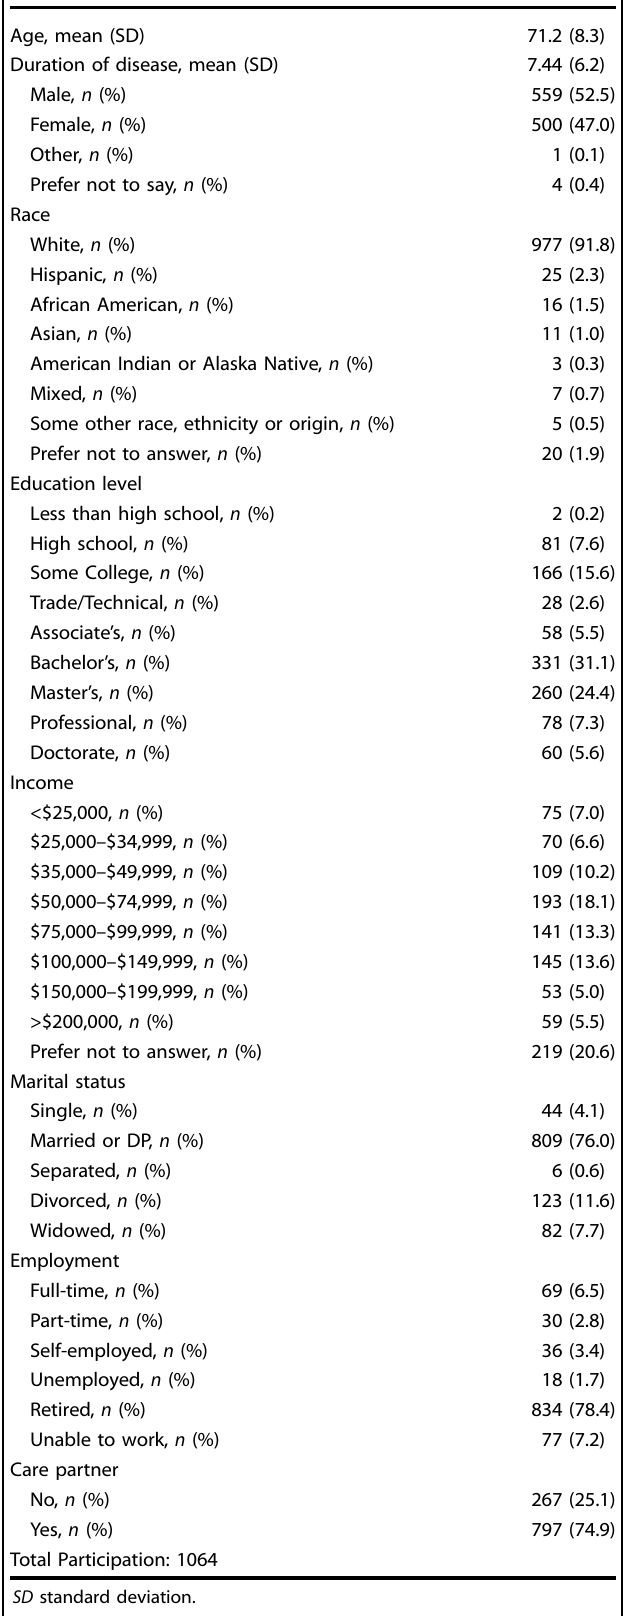
Table 1. Characteristics of the study